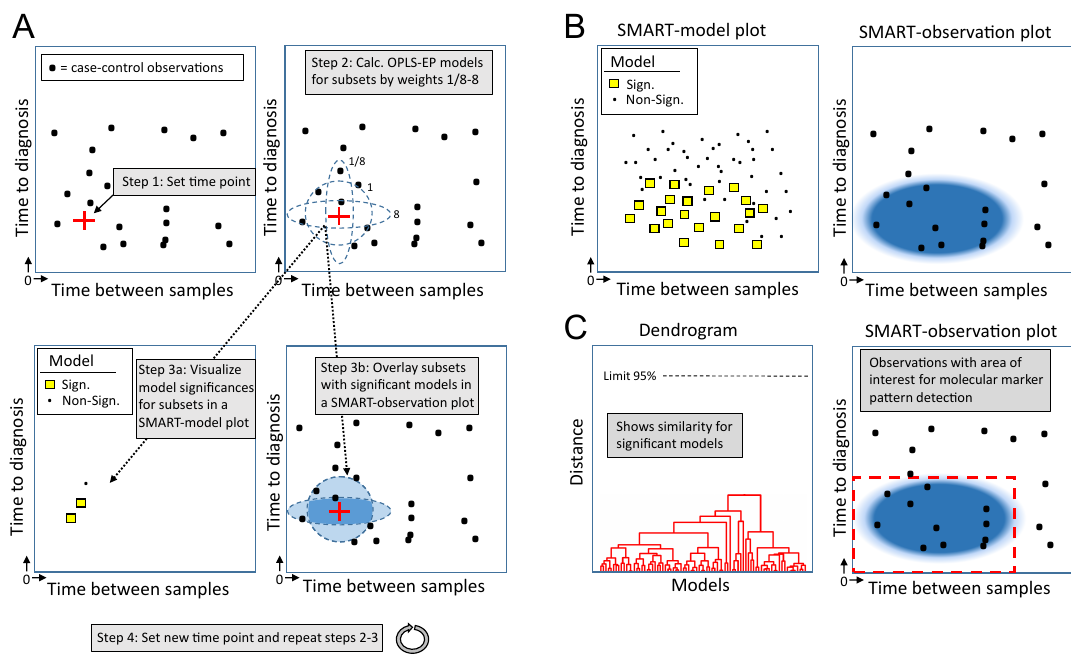
Figure 1. Schematic outline of the Subset analysis of Matched Repeated Time points (SMART) procedure. ( A ) Each case-control observation, containing information for disease progression (Equation (2)), is plotted in a scatter plot according to time to diagnosis and time between repeated sampling. Step 1: The algorithm selects a random time point in the scatter plot. Step 2: Weights are used to scan the area surrounding the selected time point, and an OPLS-EP model is calculated for every subset of case-control observations closest in time (distance) to the selected time point. For simplicity, this illustration shows only three weight used for scanning (ellipses 1 / 8, 1 and 8), generating three subsets and three corresponding OPLS-EP models. Step 3a: Significance of the calculated OPLS-EP models is visualized in a new scatter plot, i.e., a SMART-model plot, where a yellow square ( (cid:3) ) marks a significant, and a black dot ( · ) a non-significant OPLS-EP model. In this illustration, two out of three subsets generated significant models. The positions of OPLS-EP model markers ( (cid:3) or · ) in the scatter plot are determined by the mean values for the case-control observations included in the analyzed subset. Step 3b: In parallel, a SMART-observation plot is generated, which shows included subsets from which significant models were obtained. This is visualized by creating a 2D density plot where the color density correlates to the number of overlaid subsets generating significant OPLS-EP models only. Step 4: A new time point is selected and previous steps are repeated until the whole matrix has been scanned. ( B ) All model significances are summarized in a final SMART-model plot, showing the distribution of significant and non-significant OPLS-EP models. In parallel, a SMART-observation plot is summarized, showing all case-control observations and the distribution pattern of corresponding subsets with significant OPLS-EP models. ( C ) Unsupervised hierarchical cluster analysis is performed to show the similarity of significant OPLS-EP models. In this illustration, only one cluster of significant models is observed in the generated dendrogram. This cluster corresponds to a region of interest, with a predictive value for molecular marker pattern detection, in the SMART-observation plot (red dashed line